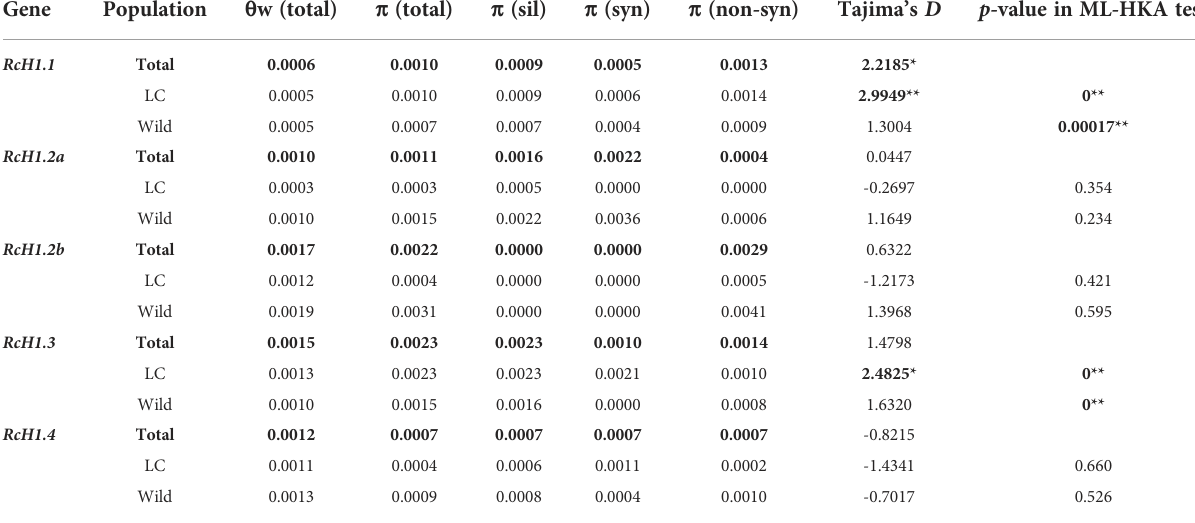
TABLE 3 Summary of nucleotide diversity, Tajima ’ s D and ML-HKA test at H1 genes in castor